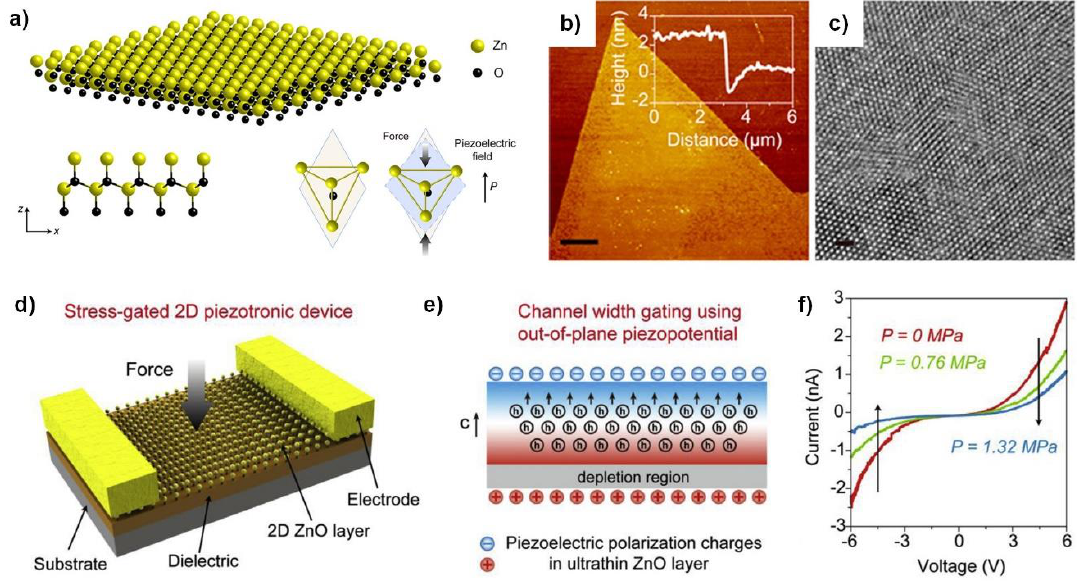
Figure 11. Atomically thin ZnO nanosheets for piezoelectric sensor applications. ( a ) Ultrathin ZnO materials with wurtzite structure and generation of a piezoelectric field under compressive pressure along the c-axis of the film. ( b ) AFM topography (Scale bar: 3 µ m) and ( c ) high-resolution (HR) TEM image (Scale bar: 1 nm) of the ZnO ultrathin film. ( a – c ) Reproduced from [64] with permission from the American Chemical Society. Copyright 2018. ( d ) Device structure of the ultrathin ZnO-based device with channel width gating e ff ect. ( e ) Schematic illustration of hole redistribution under compressive stress and the formation of the depletion region in ZnO ultrathin film. (f) I-V characteristics of the device under di ff erent applied pressure values. ( d – f ) Reproduced from [63] with permission from Elsevier Limited. Copyright